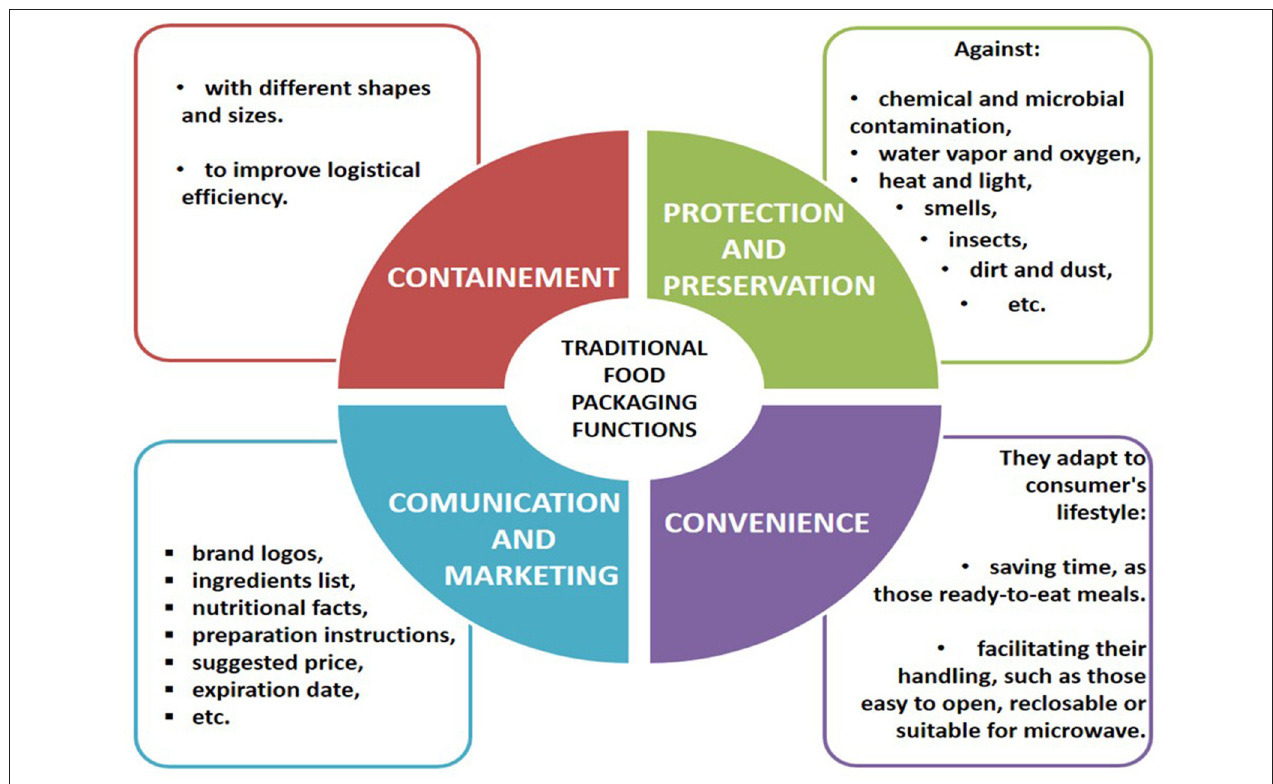
FIGURE 1 | Traditional food packaging